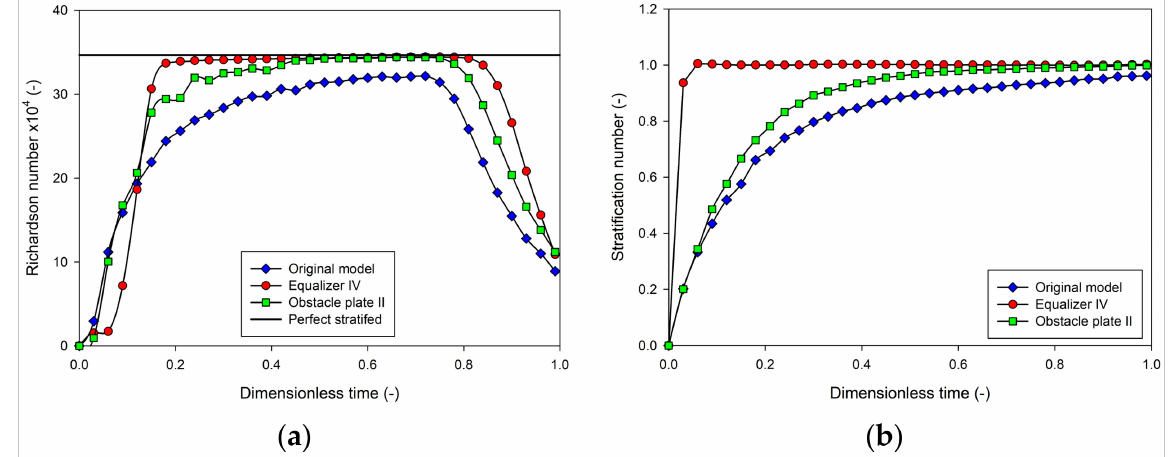
Figure 24. The comparative analysis between the equalizer IV and the obstacle plate II models: ( a ) the Richardson number; ( b ) the stratification